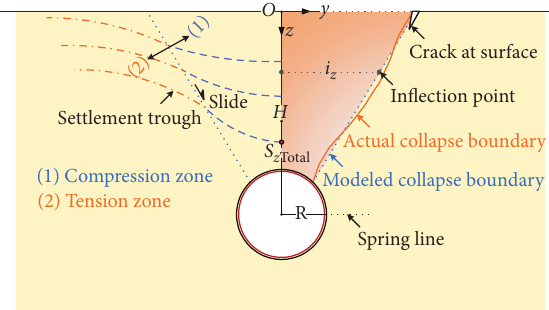
Figure 4: Schematic of ground collapse into tunnel